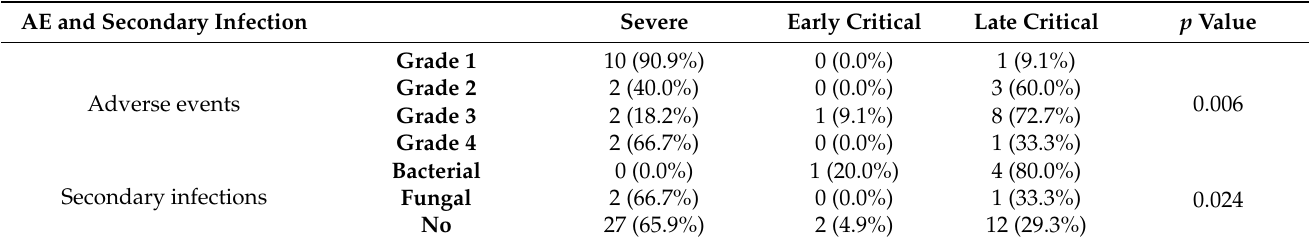
Table 4. The association between each secondary infection and adverse events post-tocilizumab with the clinical